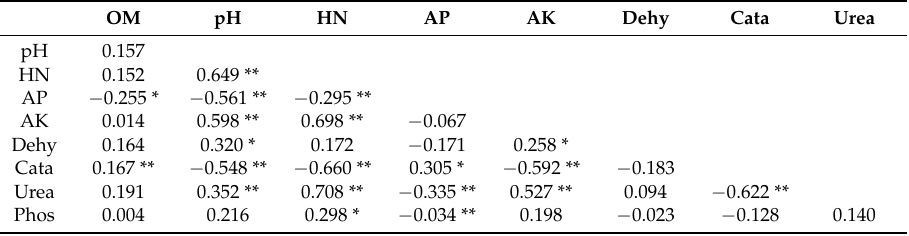
Table 5. Pearson correlations of organic matter contents (OM), pH values (pH), hydrolytic nitrogen